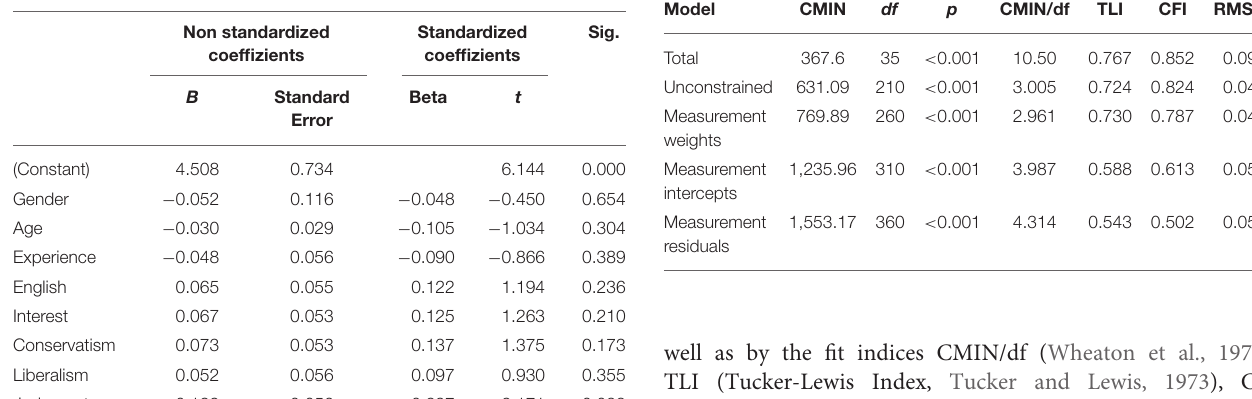
TABLE 8 | Linear regression model predicting the score on the UN-scale in the Slovakian sample.